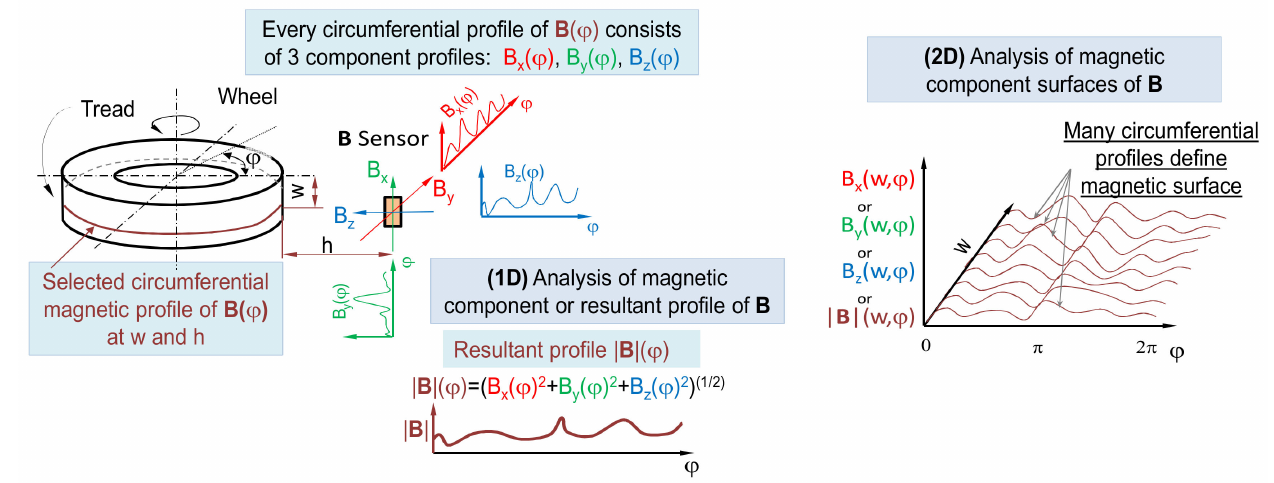
Figure 2. Schematic of magnetic circumferential profile measurement (1D) and magnetic plane measurement (2D). The second measurement method is the (2D) spatial scan over tire’s tread